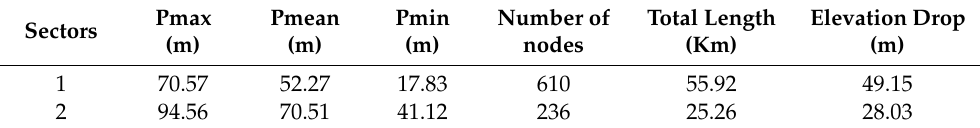
Table 2. Pressure and other data for each